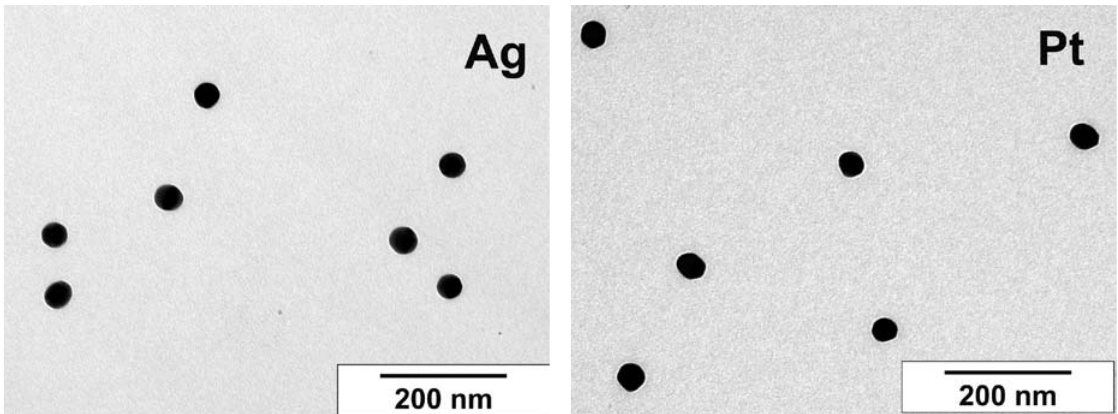
Fig. 2 TEM micrographs of the sintered and size-selected metal particles (left: 47 nm silver; right: 47 nm